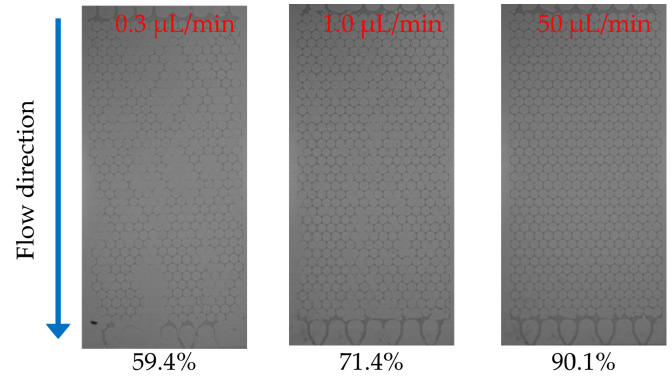
Figure 11. Snapshots of 10 ‐ g/L PAM solution injection into the micromodel.